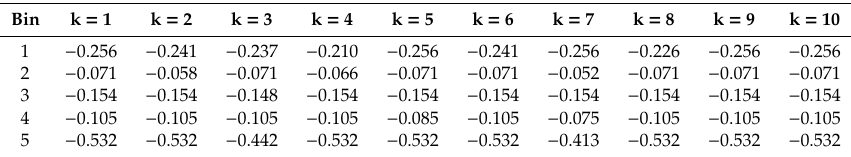
Table A2. Bias value for PJM